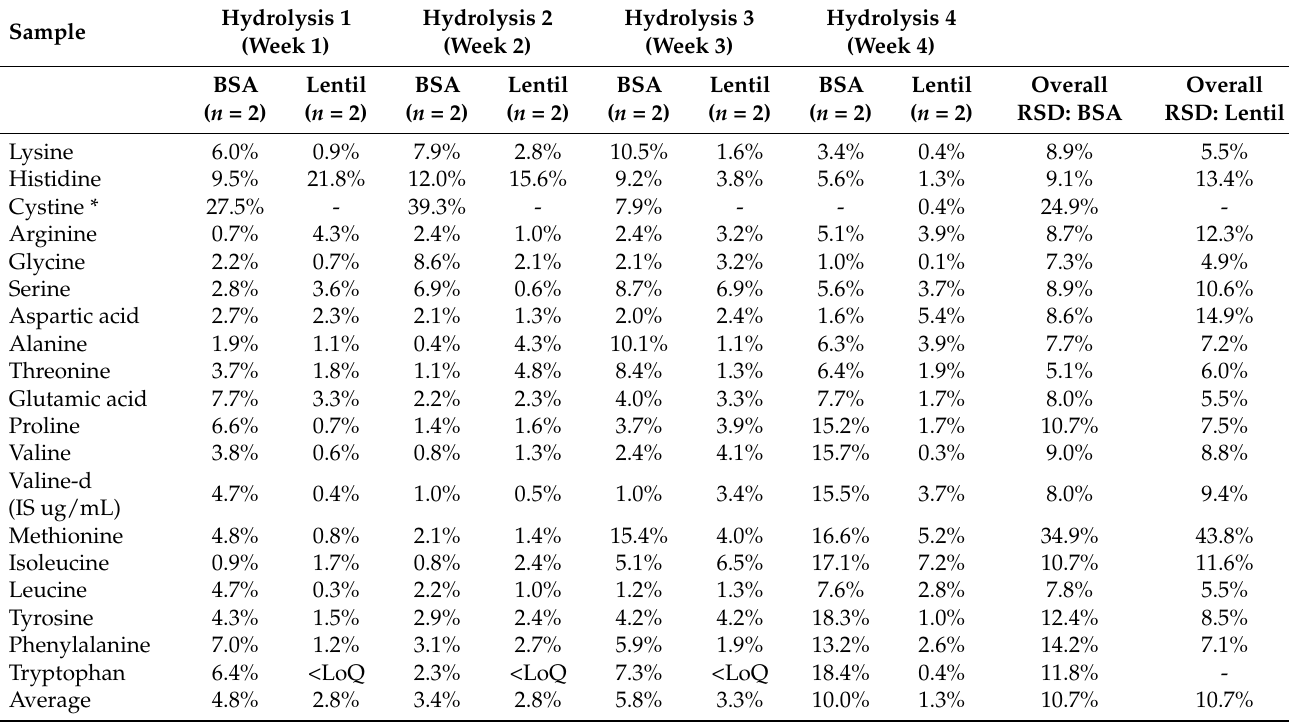
Table 4. The average relative standard deviations (RSD) of the peak area 1 in a sample injected two times in four hydrolysis batches on two different matrices (lentil and BSA) analysed over 4